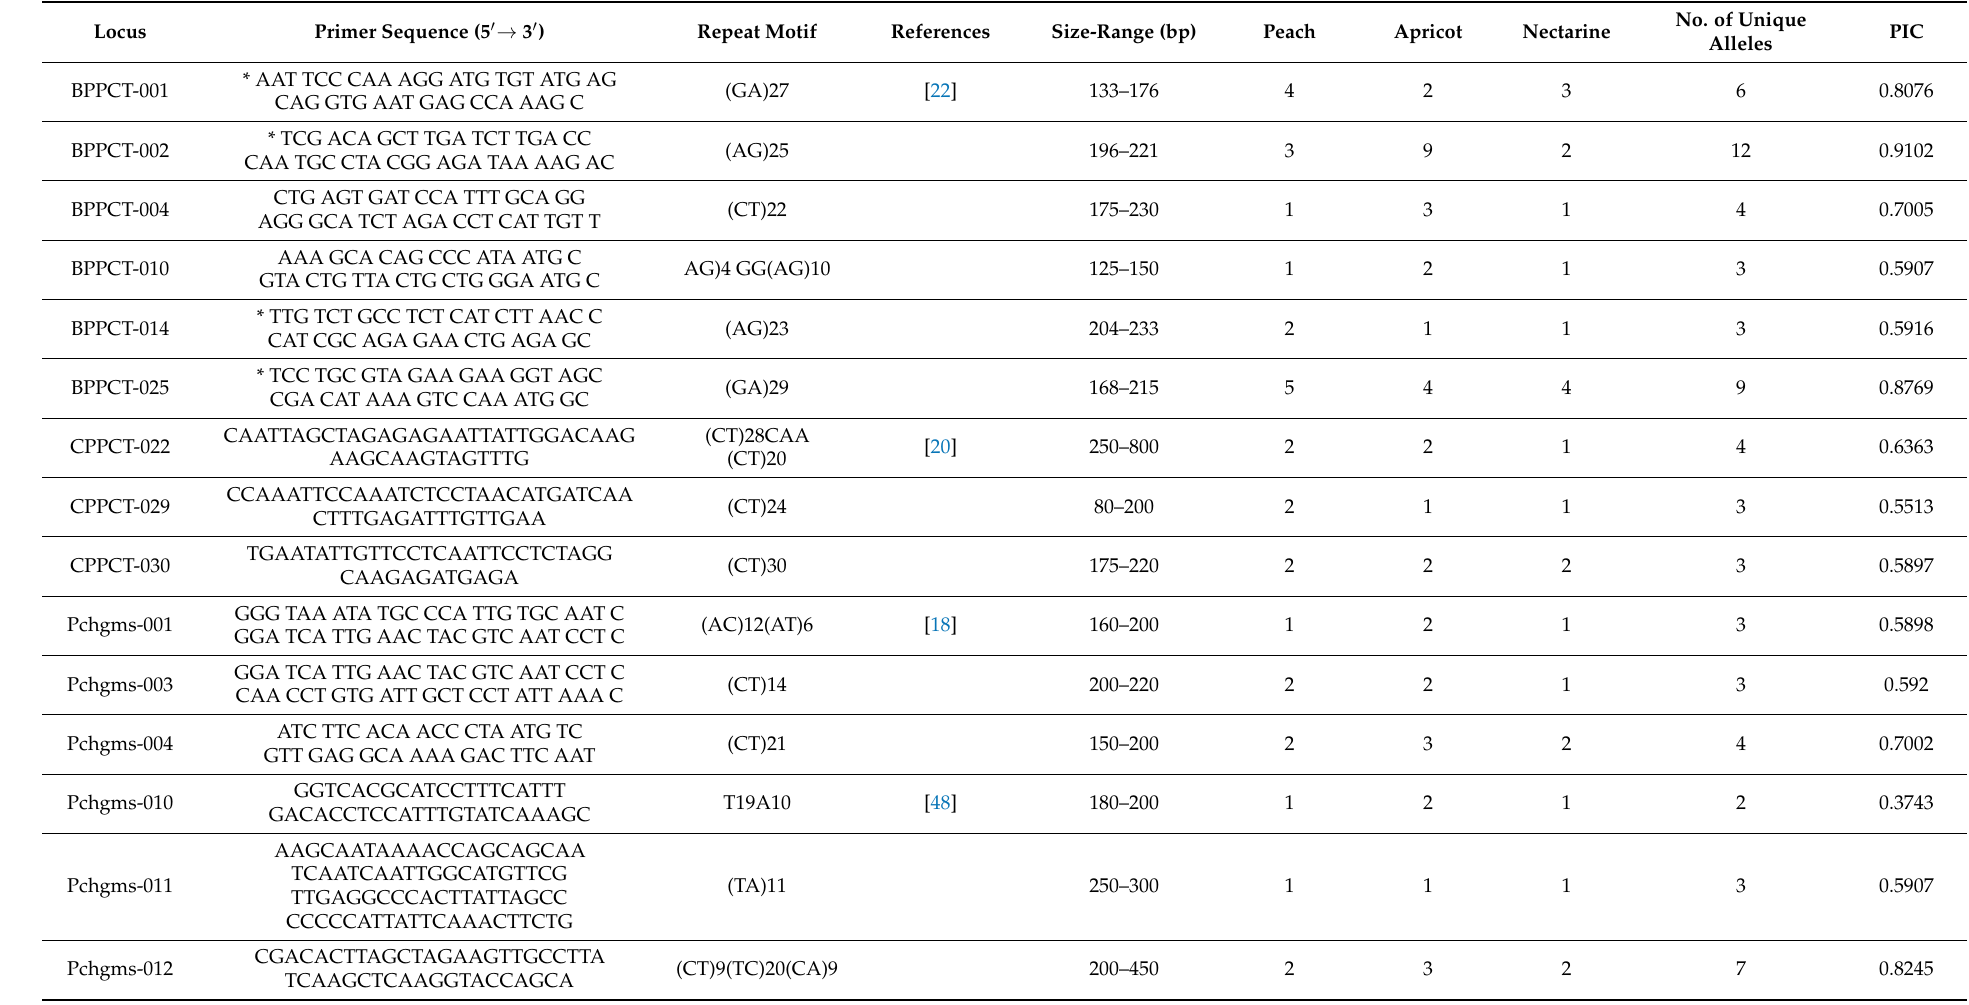
Table 2. Number of observed alleles per locus among Prunus